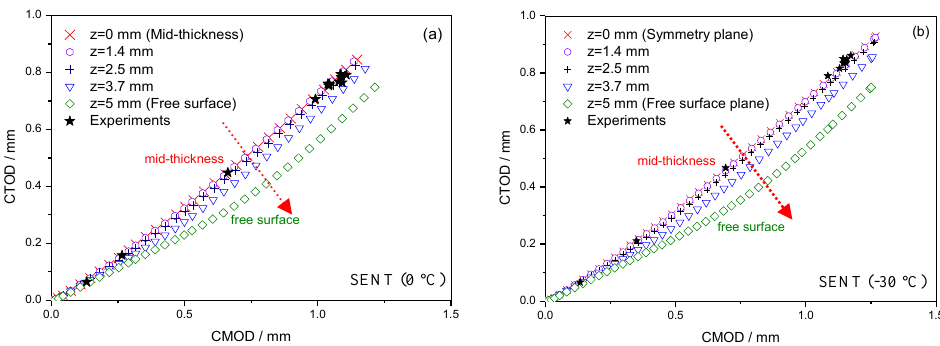
Figure 13. CTOD vs. CMOD relations at different layers through the specimen thickness for the SENT specimens considering crack growth at ( a ) 0 °C; ( b ) −30 °C.